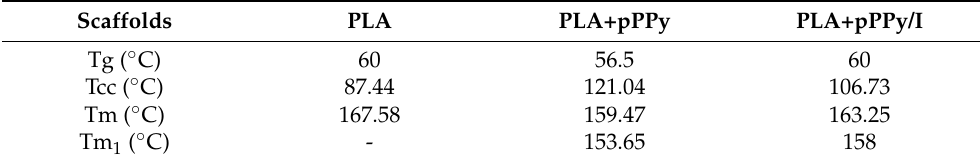
Figure 6. DSC curves of PLA, PLA+pPPy and PLA+pPPy/I. Table 2. Thermal properties of fabricated